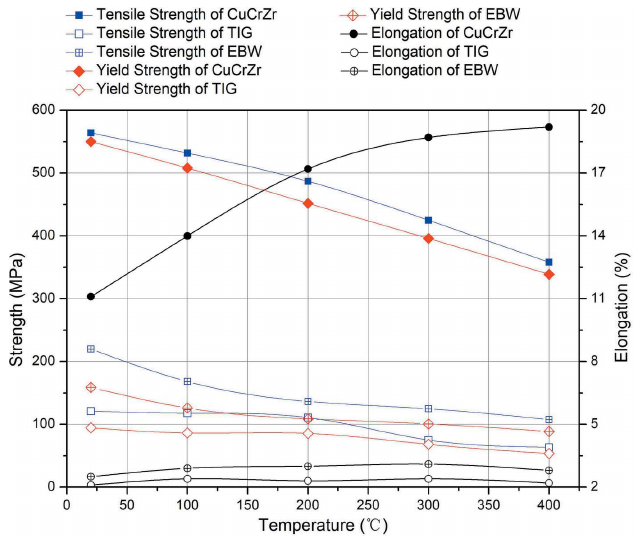
Figure 2 Welded joints versus bulk CuCrZr.